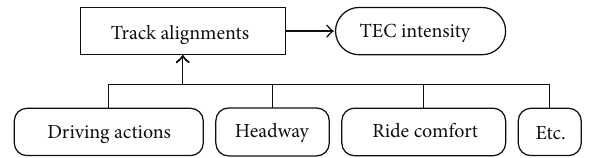
Figure 3: Track alignment design and utilization for reducing TEC